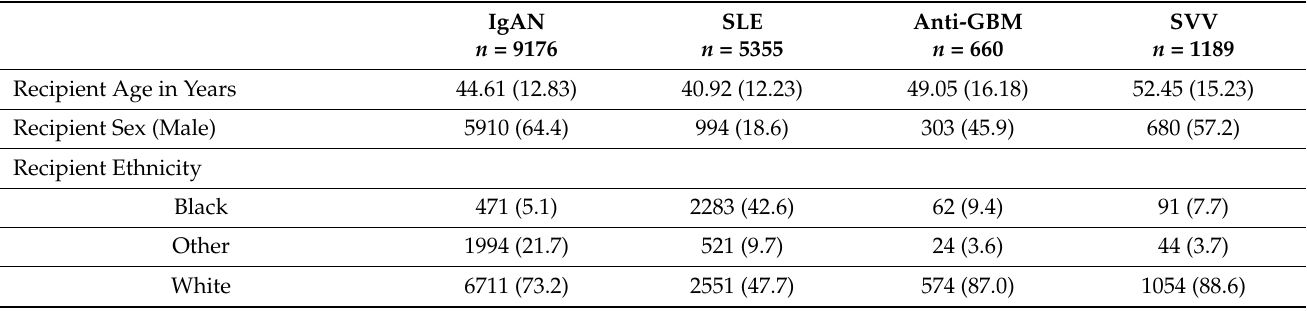
Figure 2. Recipient Survival by Glomerulonephritis Type.